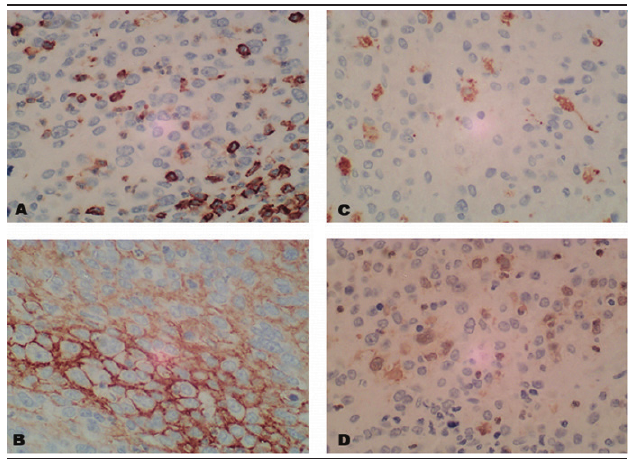
FDCS: follicular dendritic cell sarcoma; CD45: ; D2-40: ; CD68: ; S100: .